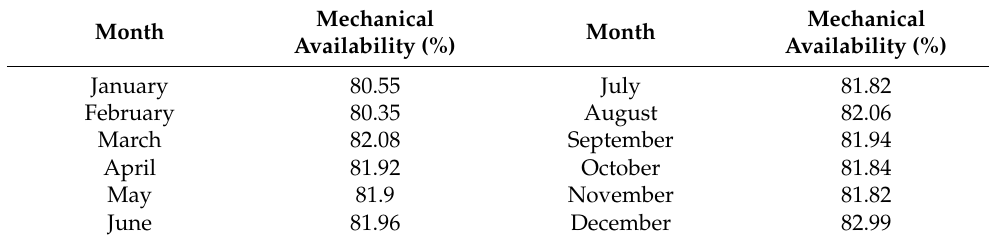
Table 9. Fleet mechanical availability planned for the year.